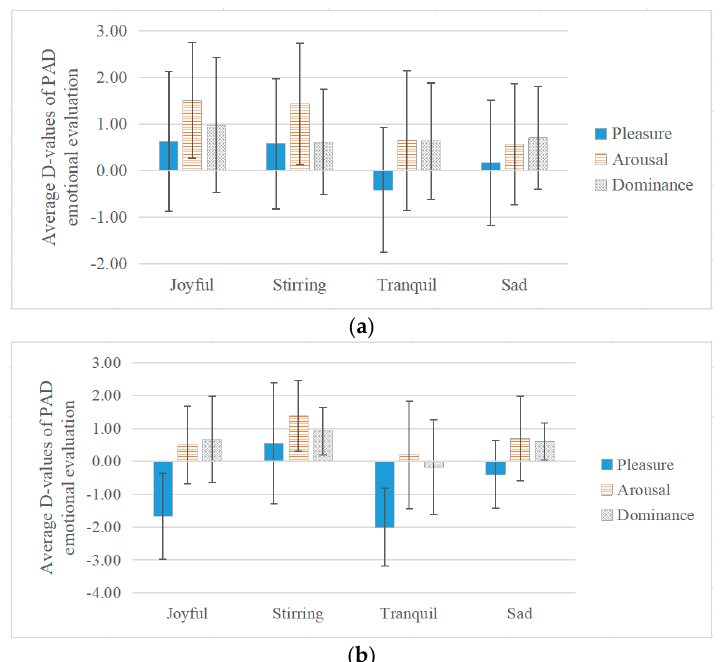
Figure 6. The Effect of Musical Emotion on PAD Emotional Evaluation during Communication: ( a ) In all participants ( b ) Negative group.